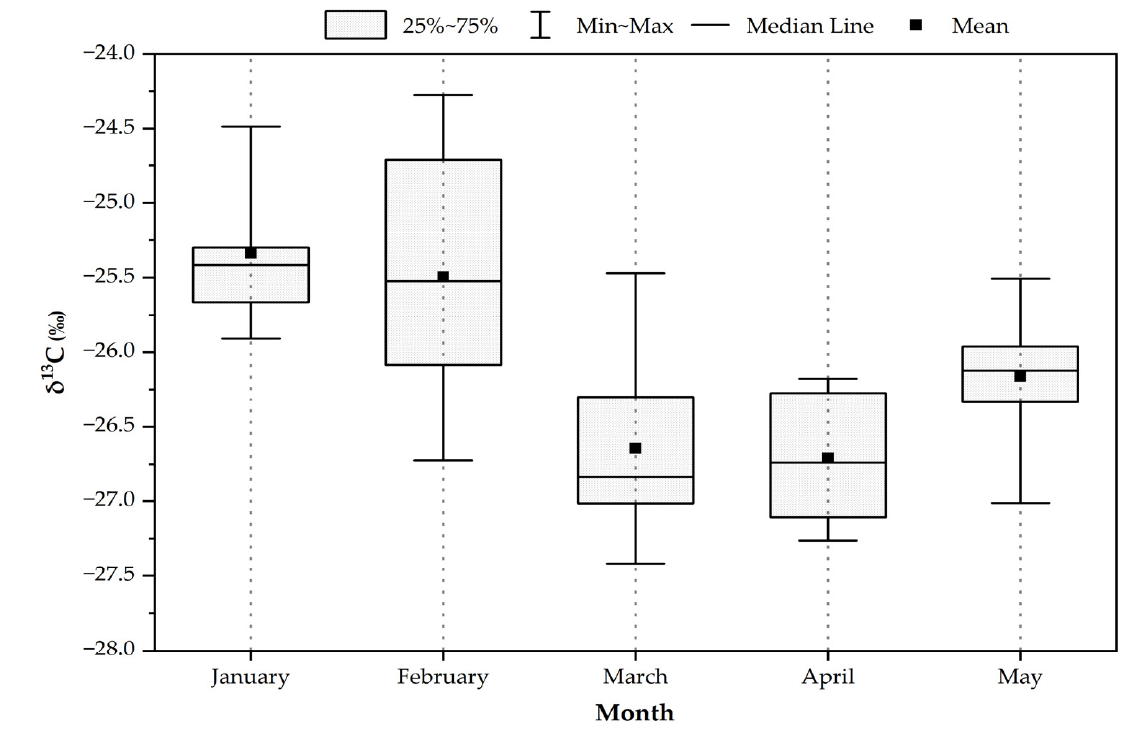
Figure 3. The box plots of stable carbon isotopes during the sample period in Chiang Mai city.